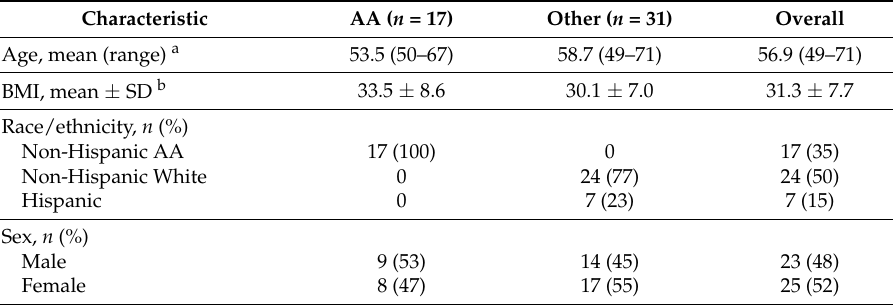
Table 1. Participant